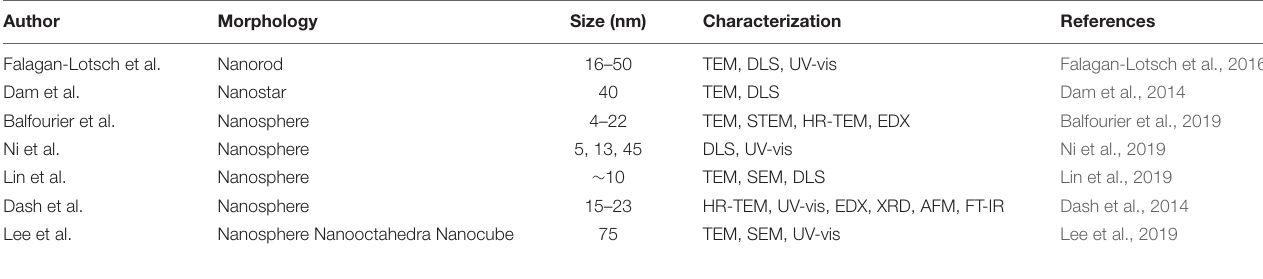
TABLE 4 | Characterization of AuNPs and its morphology and